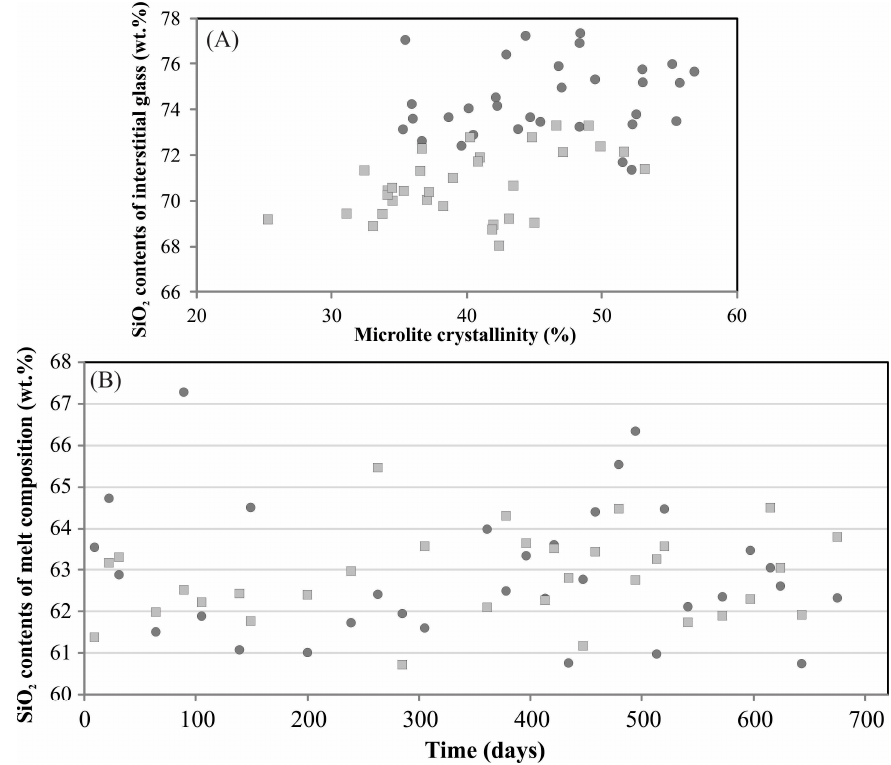
Figure 7. ( A ) the SiO 2 content of interstitial glass vs. microlite crystallinity; and ( B ) the calculated SiO 2 content of melt composition (interstitial glass + microlites). BVVR (solid rectangle) and BVR (solid circle) over the